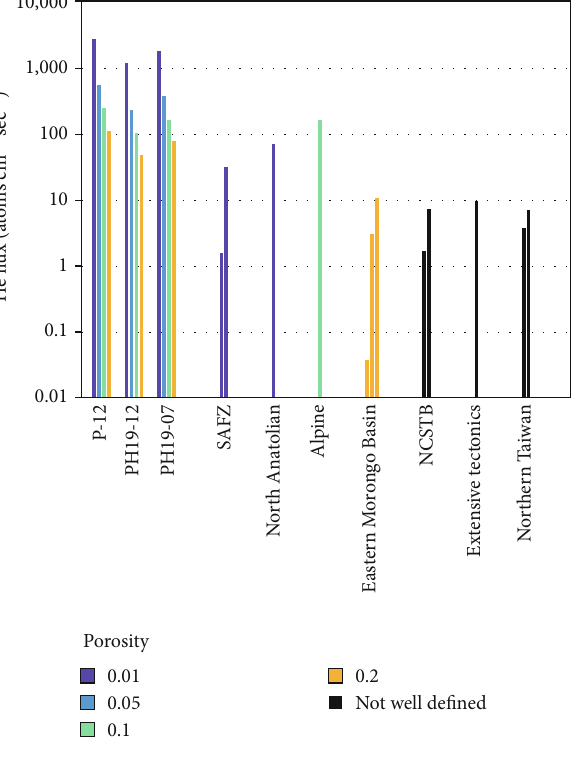
Figure S1: (a) relative concentration of CO (b) CO /N and pH plot. (c) CO 2 2